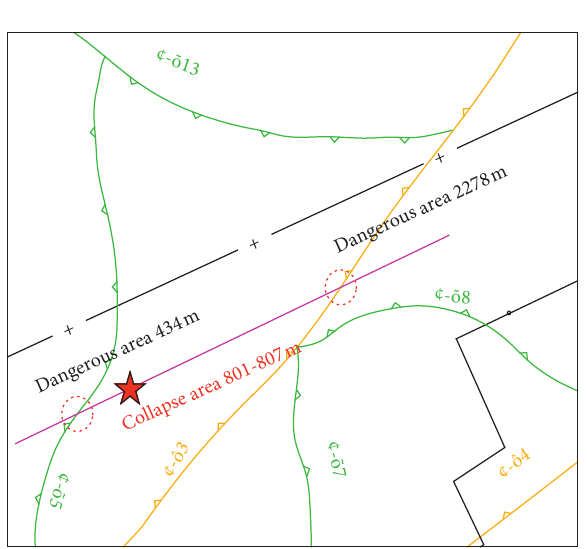
Figure 5: Relationship between roof fall area and fault